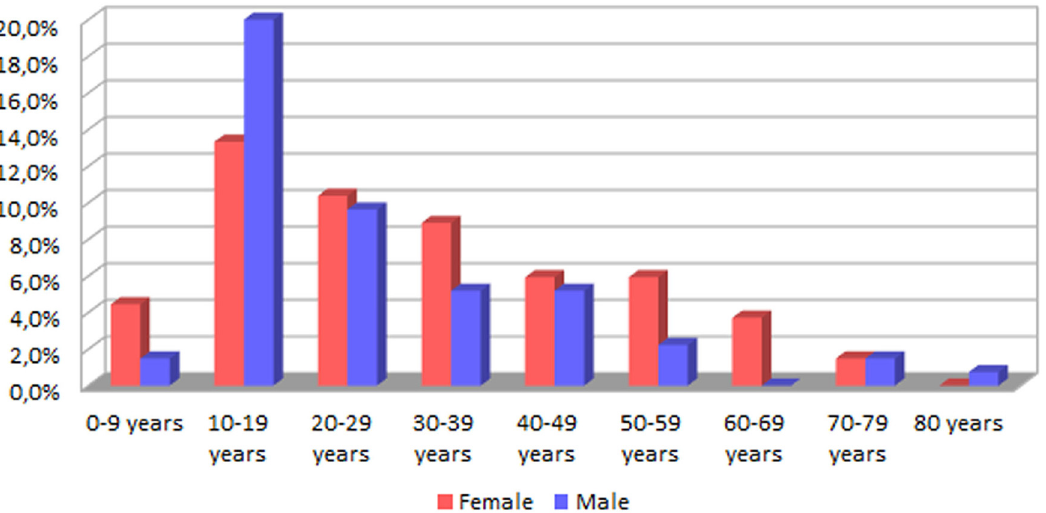
Fig. 2. Distribution of central odontogenic fi broma by age and